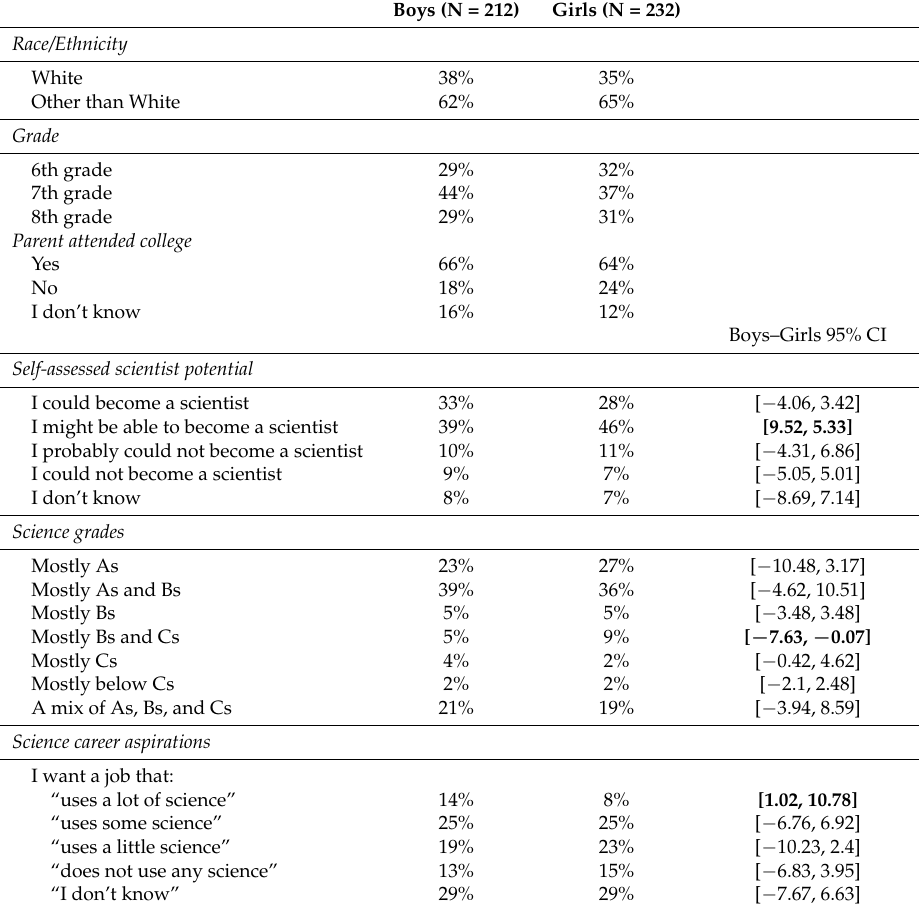
Table 1. Sample Descriptive Statistics by Gender with Significance Tests for Focal